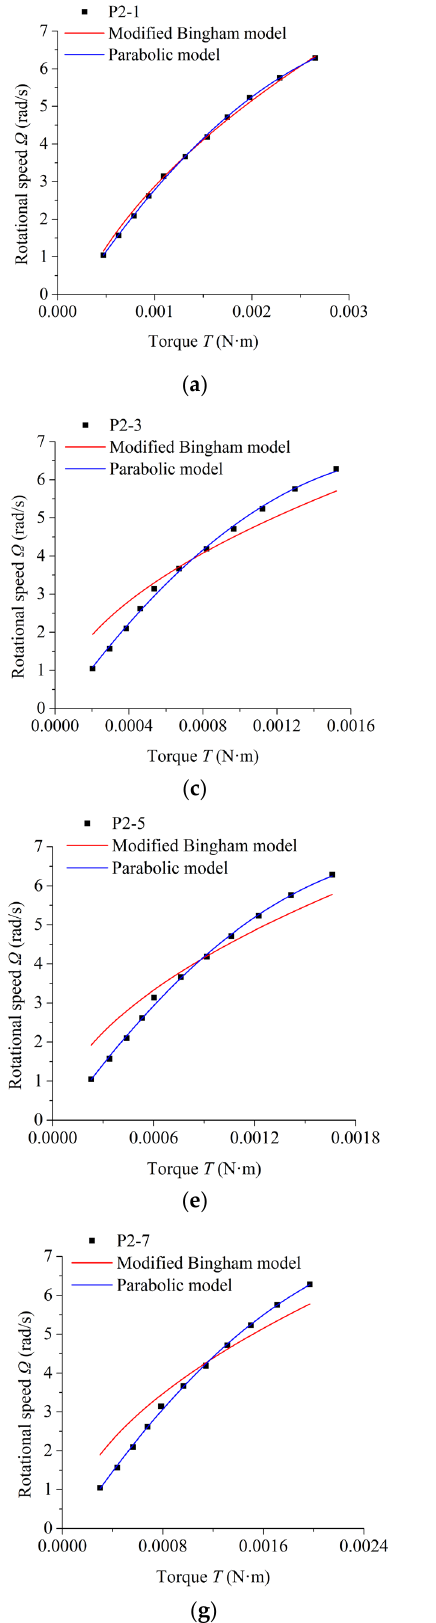
Figure 5. Comparison of fitting results of P2 between modified Bingham model and parabolic